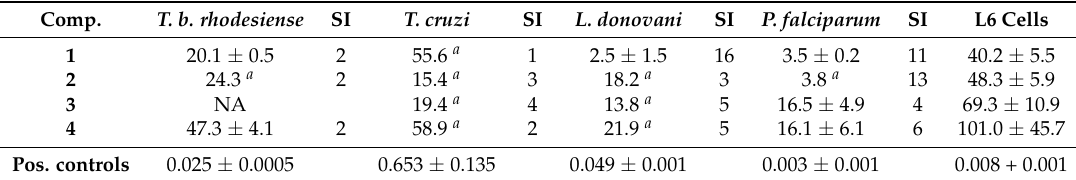
Table 3. IC 50 (geometric mean of 2 experiments ± SE) of the isolated compounds ( µ M) tested against T. b. rhodesiense , T. cruzi , L. donovani , P. falciparum and L6 cells. The selectivity index (SI) determined with L6 cells is also